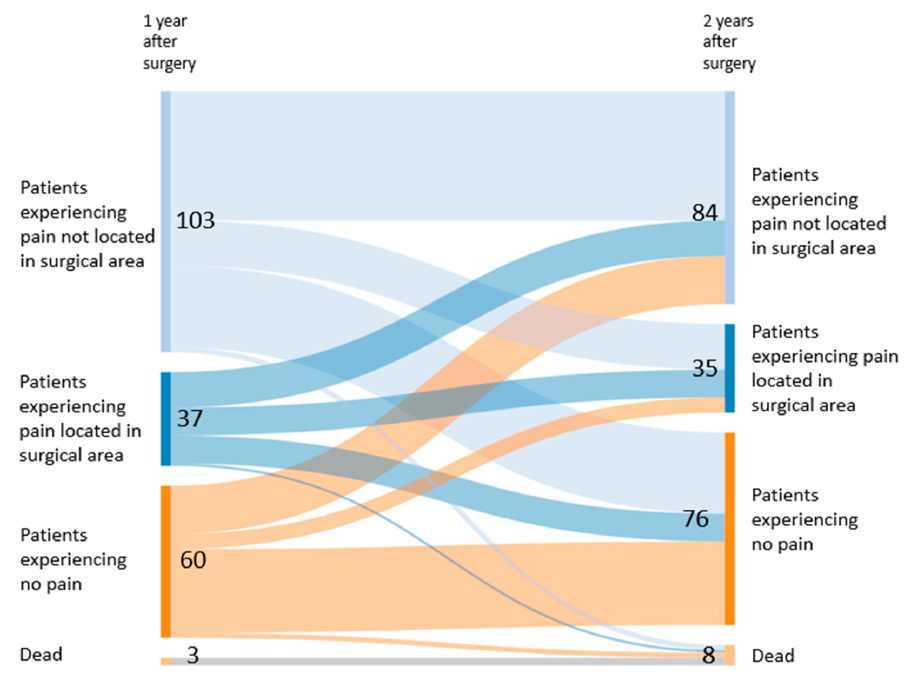
Figure 5. Pain localisation trajectories between the first and the second postoperative year. 3.3. Similarities and Differences in Patients with Pain after One and Two Years